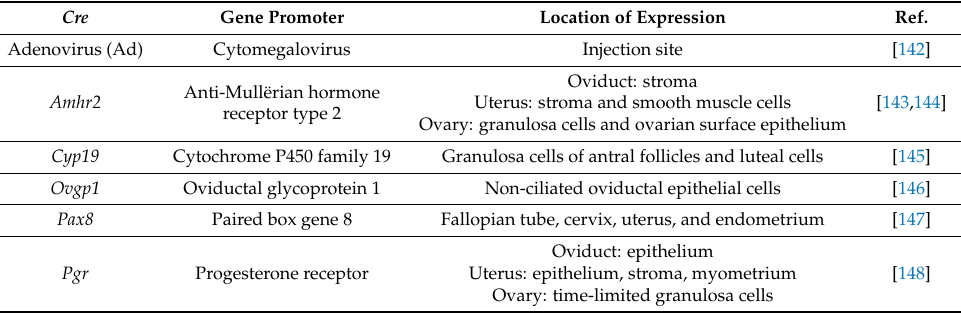
Table 1. Cre recombinase promoters and site of